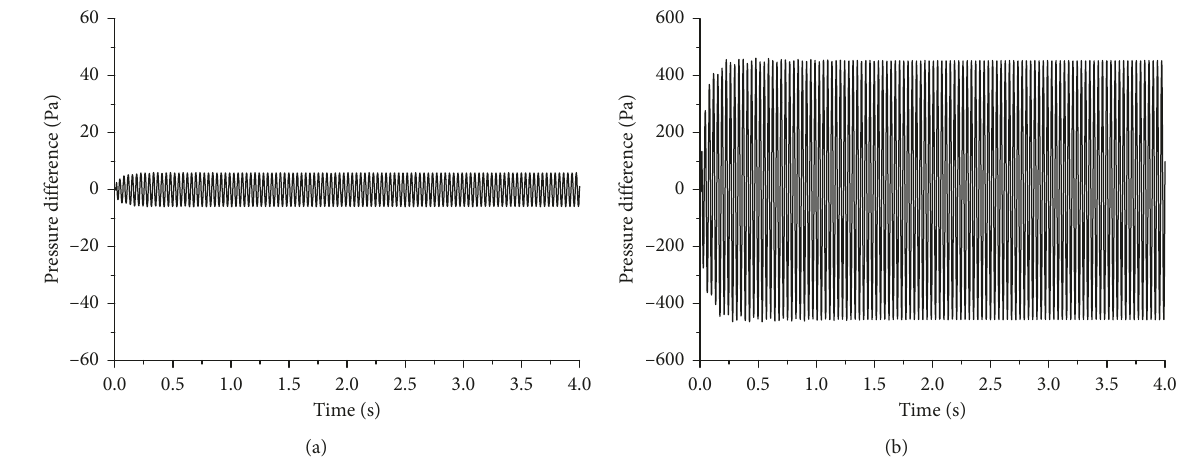
Figure 10: Pressure difference of the branch pipe in two directions: (a) x direction; (b) y